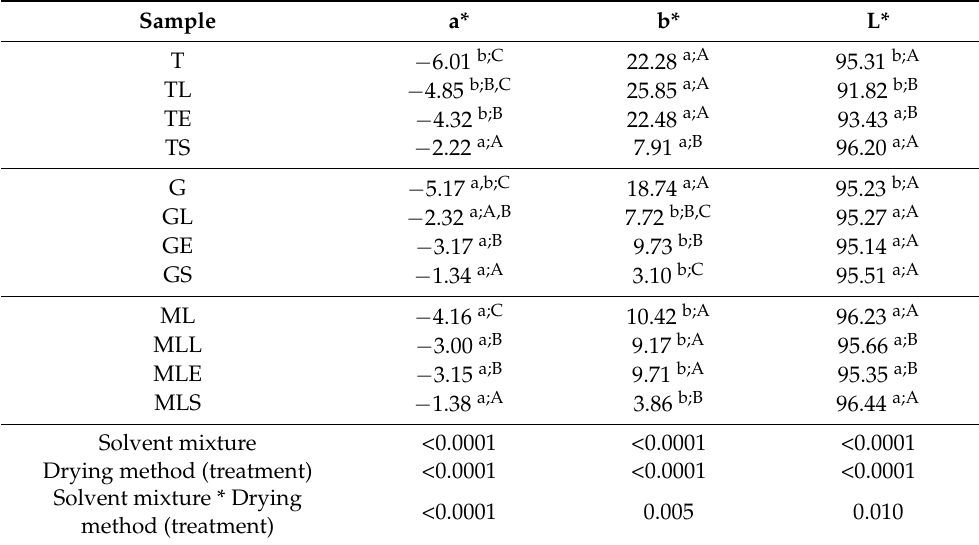
Table 3. CIE coordinates of the color space regarding the different samples of tomato by-product extracts. L* indicated the lightness, a* the red/green coordinate, and b* the yellow/blue. Higher values of a* are redder, while higher values of b are more yellow rather than